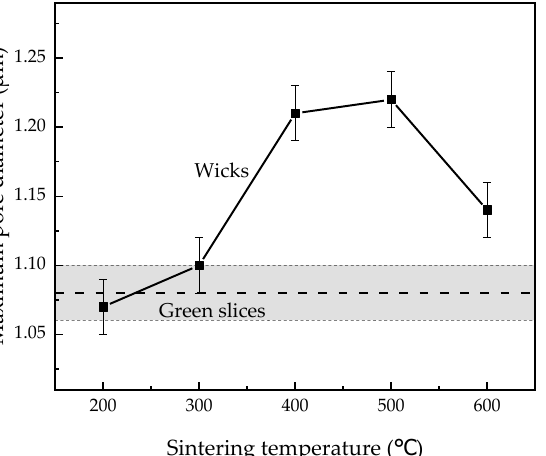
Figure 8. Maximum pore diameter of green slices and wicks sintered at different temperatures.